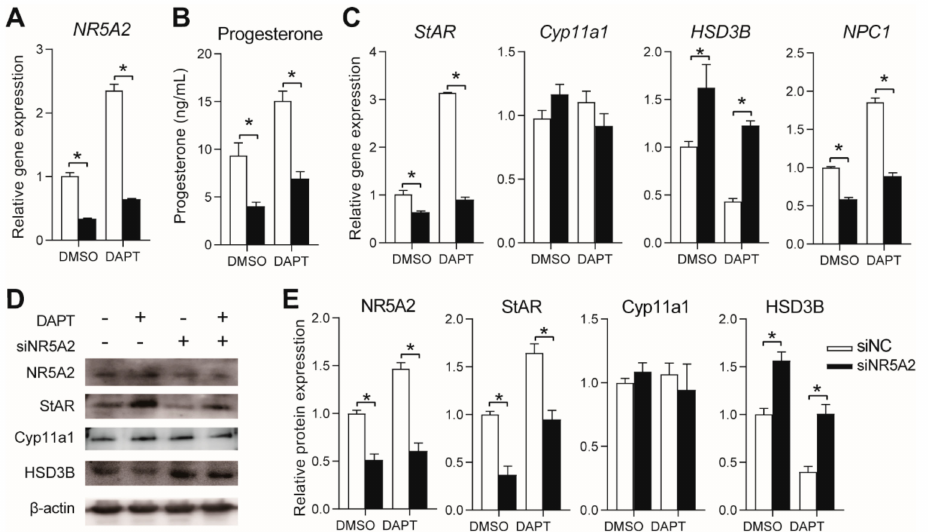
Figure 4. E ff ects of NR5A2 knockdown on progesterone biosynthesis. ( A ) gene expression of